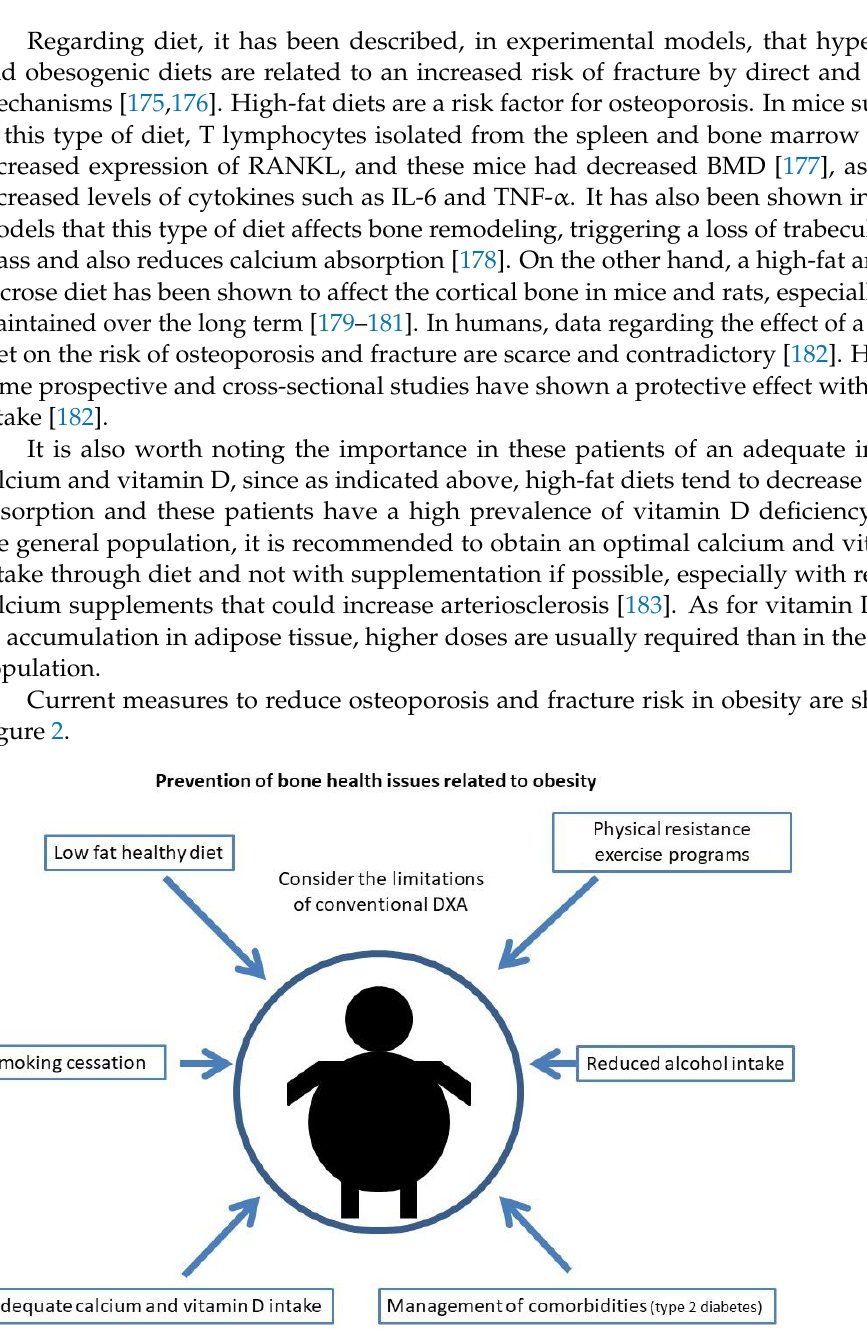
Figure 2. Current measures for the prevention of bone health issues related to obesity.